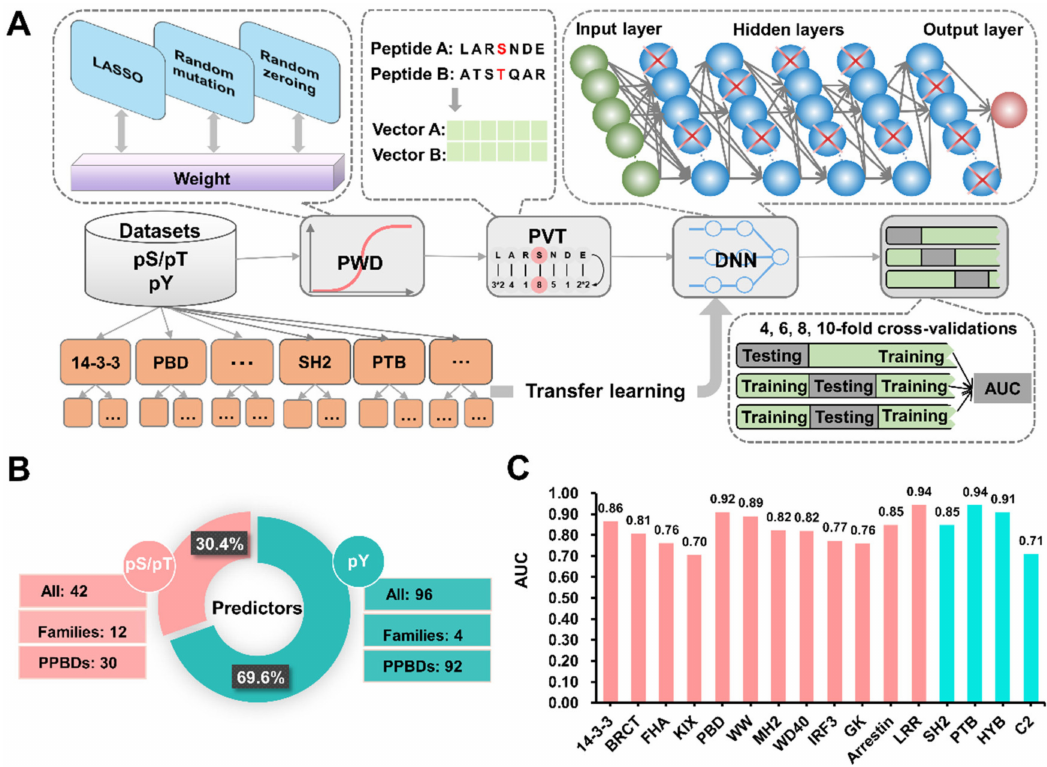
Figure 3. The implementation and accuracy of GPS-PBS. ( A ) The procedure of model training in the updated GPS algorithm, in which the basic scoring strategy, PWD and PVT, were implemented to transform single similarity scores into 231-dimensional vectors. A deep learning framework of seven-layer DNNs was adopted to train two models for the pS / pT and pY groups, respectively. Then, transfer learning was adopted to obtain models in family and single PPBD cluster levels. ( B ) The statistics of individual predictors in the pS / pT and pY groups. ( C ) For the 16 PPBD families, the AUC values were calculated from the 10-fold cross-validation or the LOO